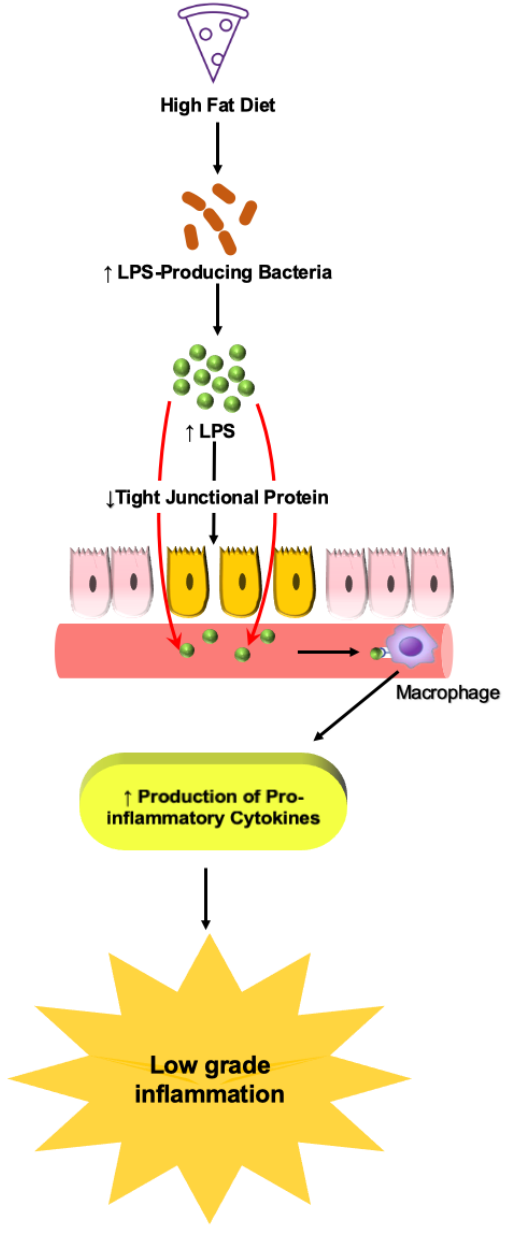
Figure 6. Mechanism of LPS-mediated immune response. High-fat diet increases the population of LPS producing bacteria in the gut. LPS producing bacteria downregulates the expression of tight junction proteins, which in turn increases intestinal permeability and translocation of LPS. In the circulation, LPS binds to its receptor on immune cells and increases the release of proinflammatory cytokines causing low-grade inflammation. LPS, lipopolysaccharide. Upward arrow indicates increased; downward arrow indicates downregulation